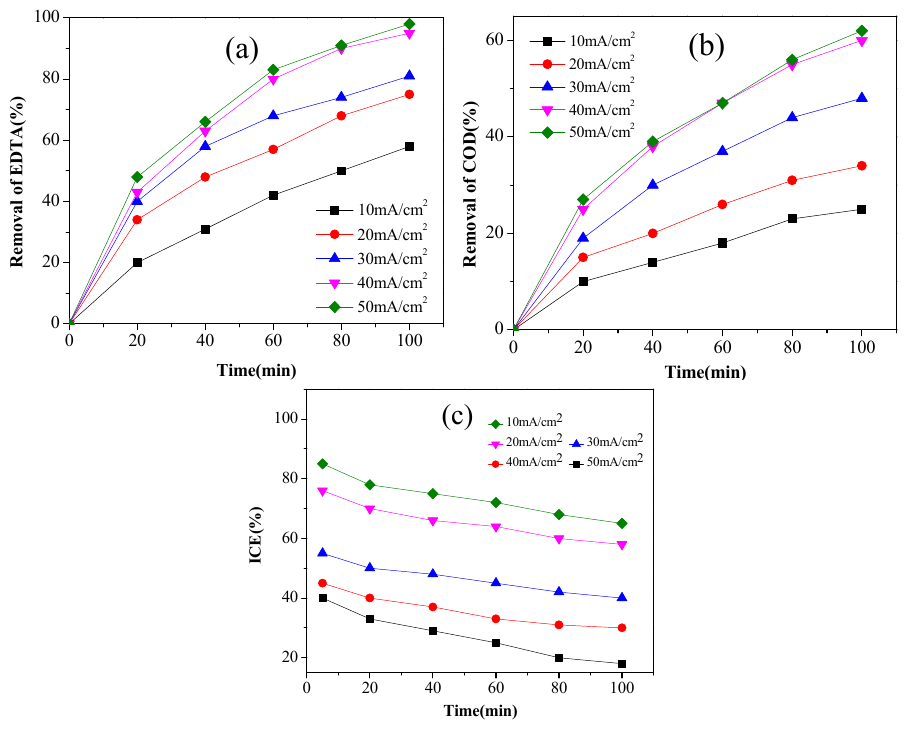
Figure 6. The effect of current density on EDTA removal ( a ) concentration; ( b ) COD; ( c ) ICE (3% Pt/ACF electrode; EDTA concentration: 300 mg/L; electrolyte concentration: 0.1 mol/L; pH 5.0). ICE: instantaneous current efficiency.